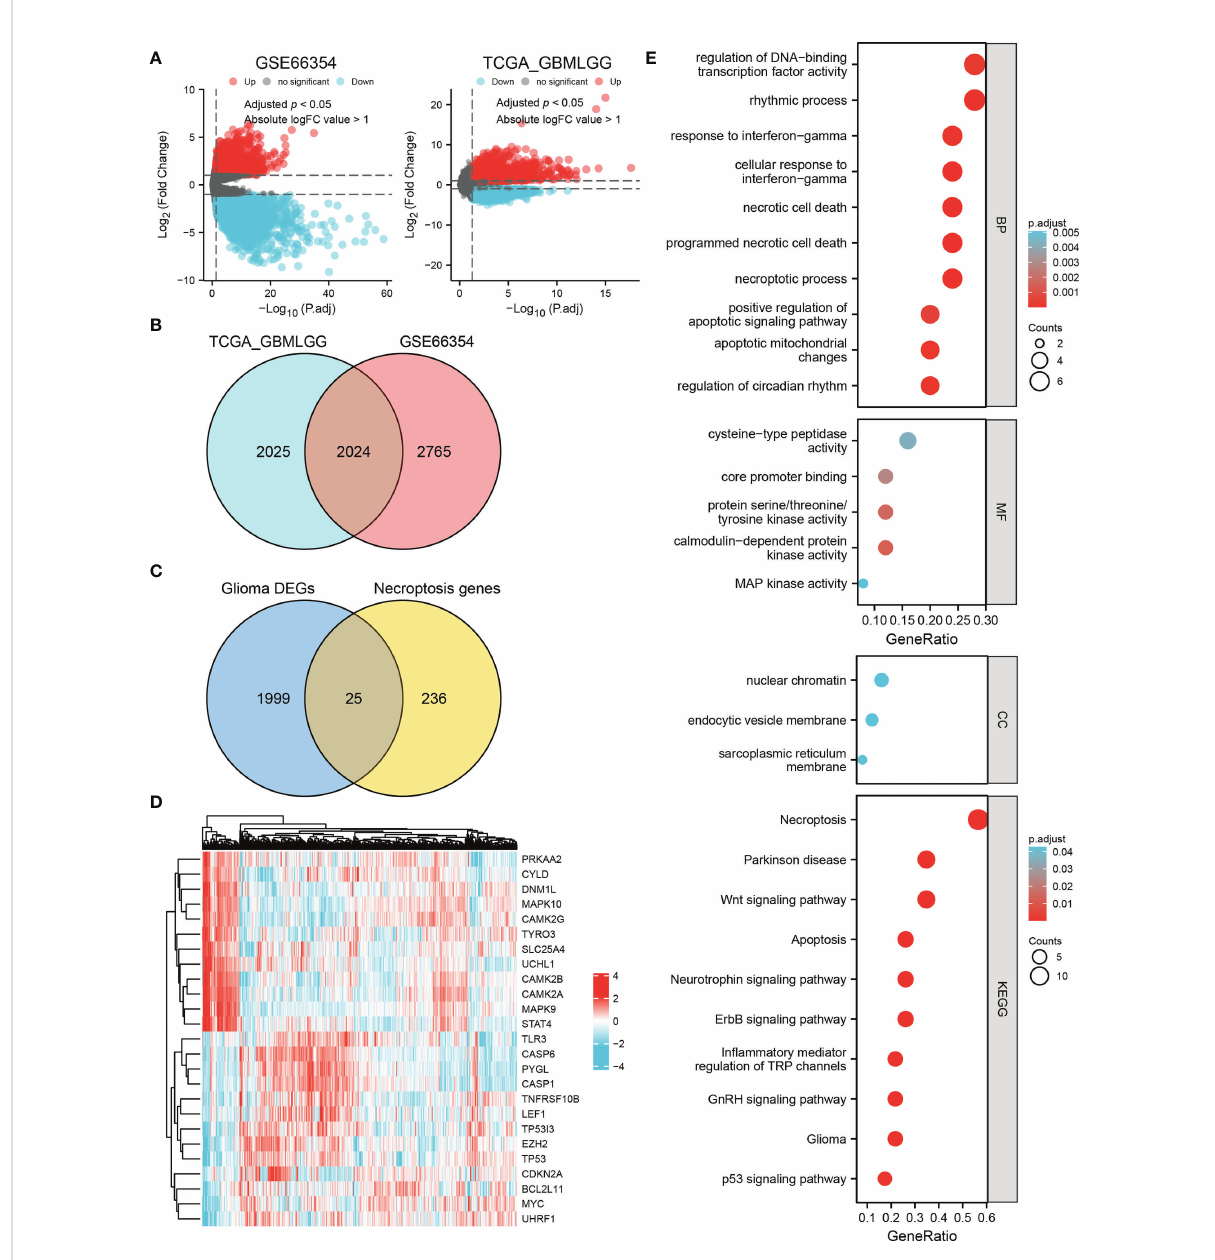
FIGURE 1 Identi fi cation of necroptosis-related DEGs in glioma and enrichment analysis. (A) Volcano plots of DEGs in the TCGA and GSE66354 datasets. Red indicates upregulated genes, and blue indicates downregulated genes. Threshold values were set as adjust p < 0.05 and absolute logFC value > 1. (B) 2024 differential genes in the intersection of these two datasets. (C) Venn diagram showing 25 necroptosis-related DEGs in glioma. (D) Heat map of the expression level of the 25 necroptosis-related DEGs in the TCGA dataset. (E) Biological process (BP), molecular function (MF), cellular component (CC), and Kyoto Encyclopedia of Genes and Genomes (KEGG) pathways are enriched for the 25 necroptosis- related